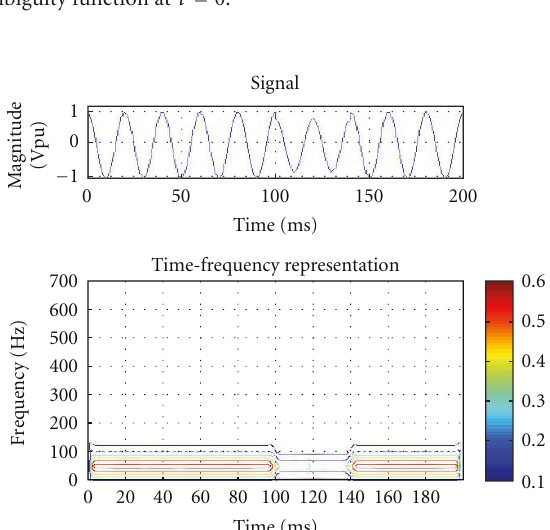
Figure 12: The TFR of sag signal using SWWVD at T g = 10ms and T sm = 0ms.